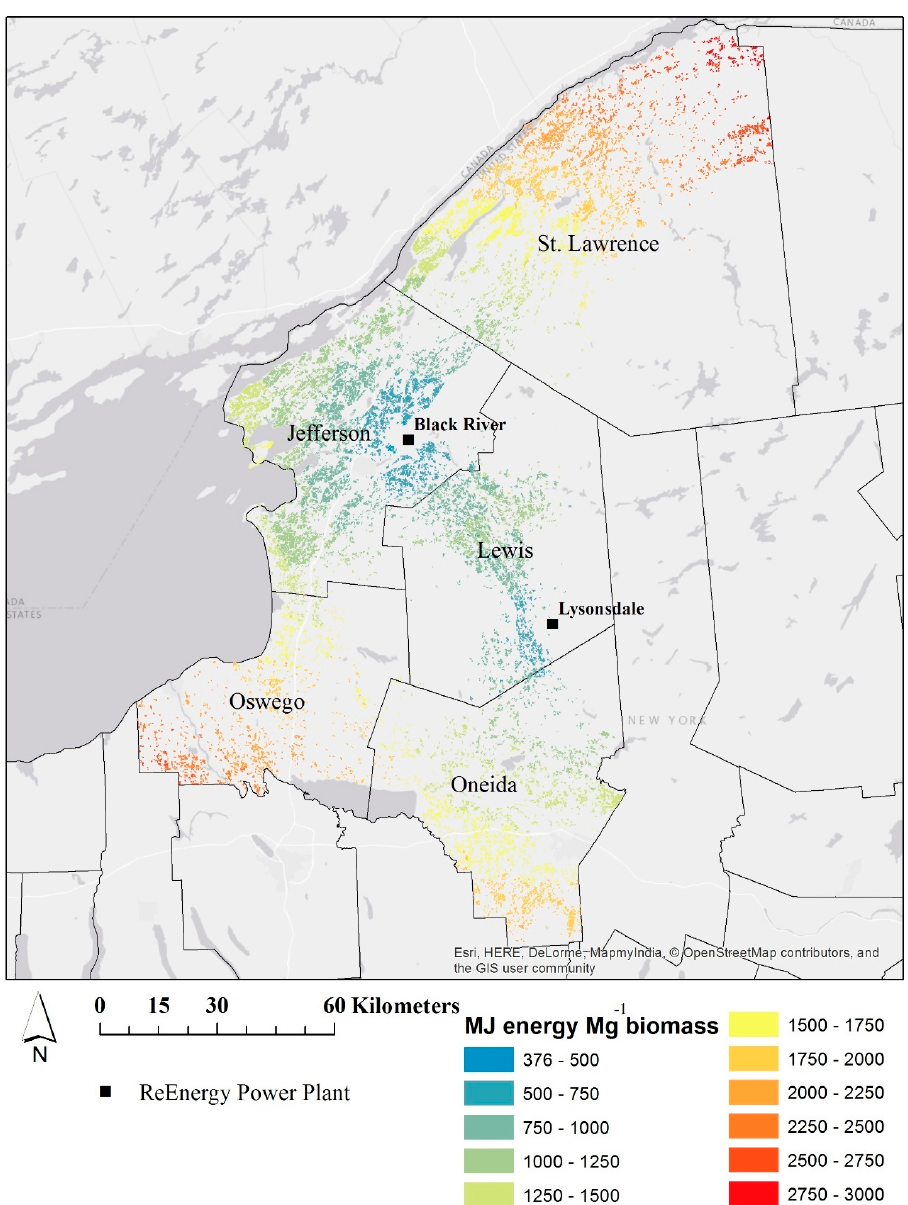
Figure 9. Energy consumption to produce 1 Mg willow biomass in the five counties in Central and Northern New York based on parcel-level LCA modeling.